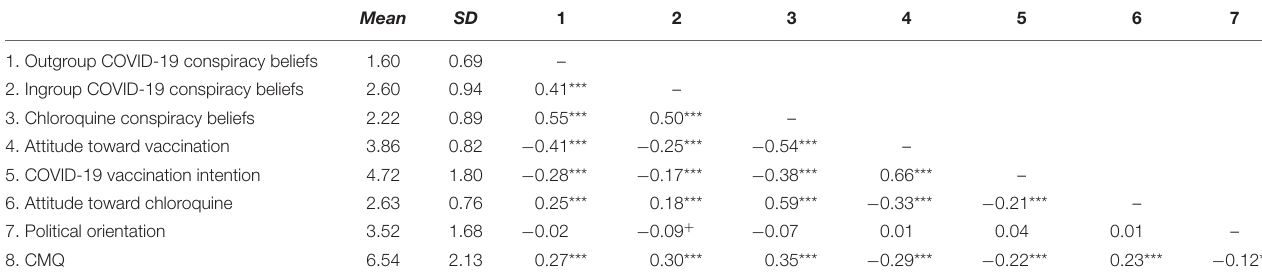
TABLE 3 | Correlations, means, and standard deviations for measured variables (study